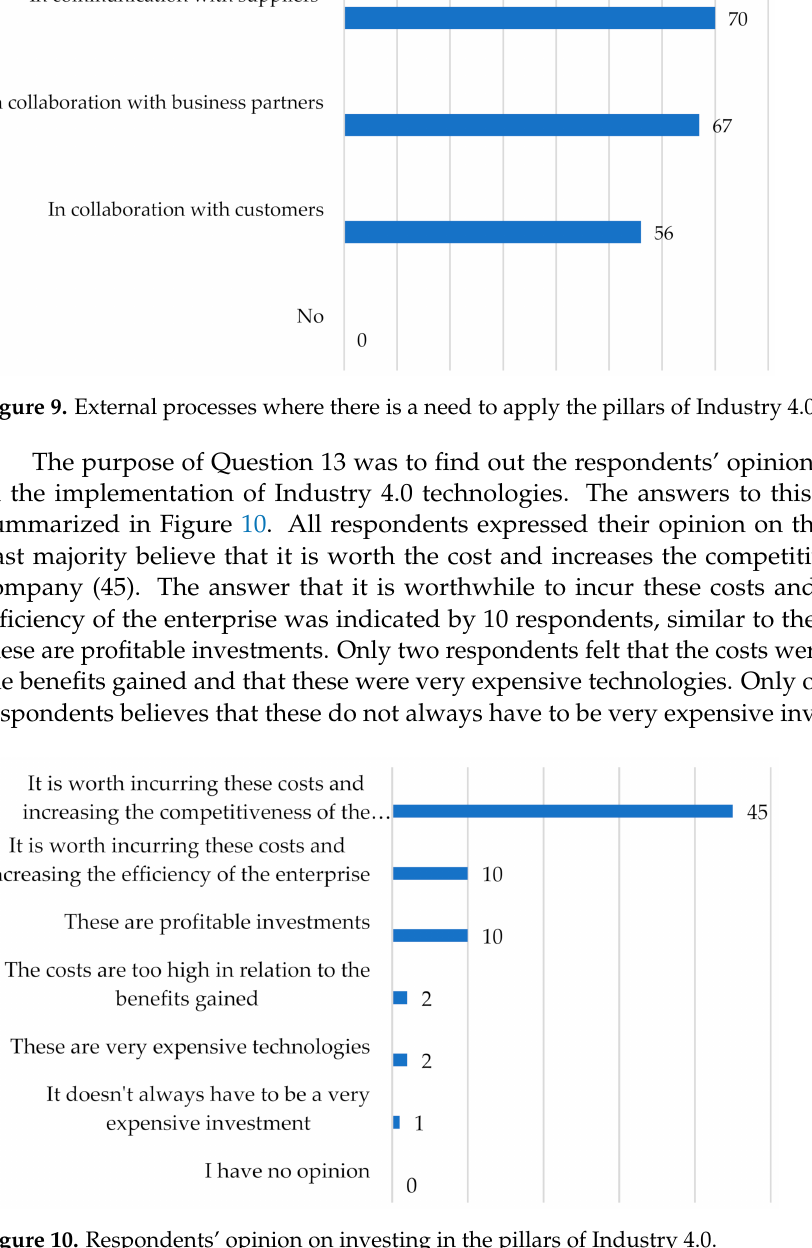
Figure 10. Respondents’ opinion on investing in the pillars of Industry